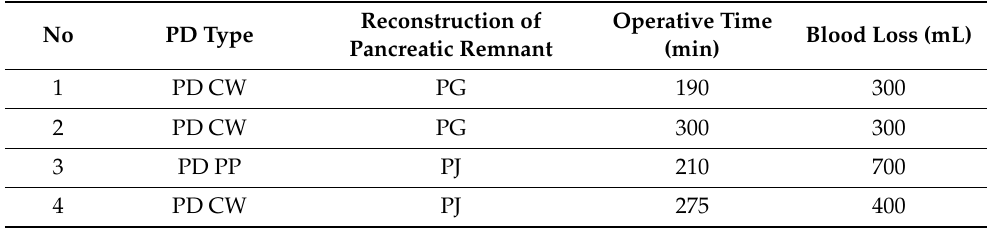
Table 2. Details regarding the surgical intervention.